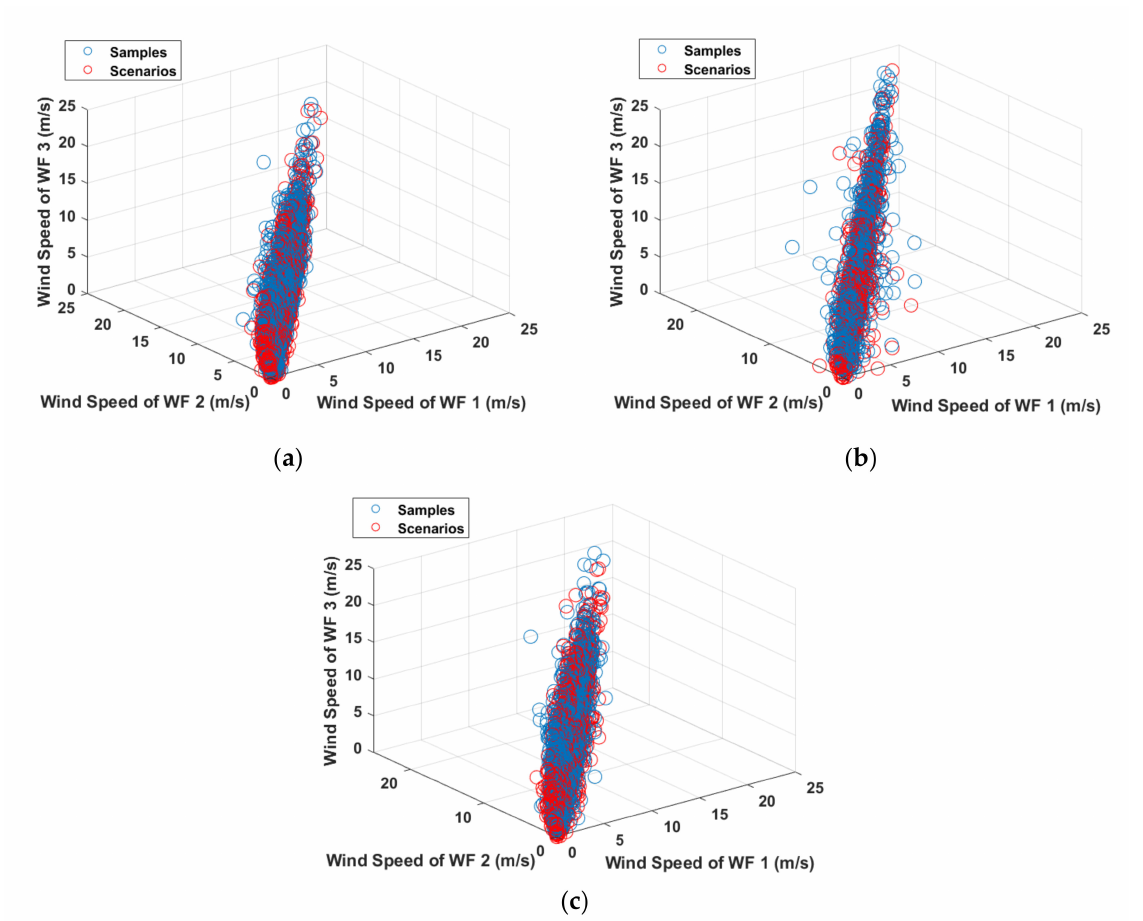
Figure 8. Wind speed samples and scenarios for the three wind farms ( a ) at the 7th hour, ( b ) at the 15th hour, ( c ) at the 23rd